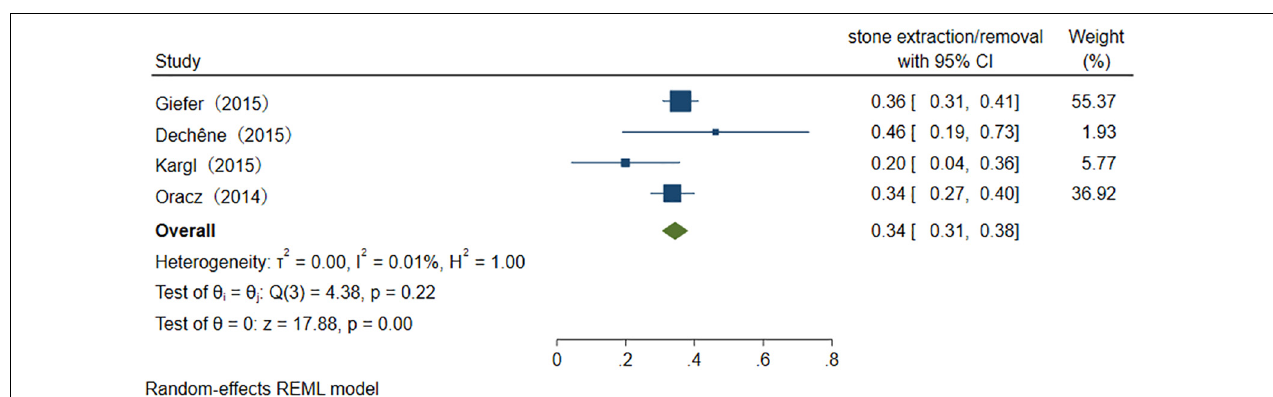
FIGURE 10 | The usage rate of sphincterotomy.